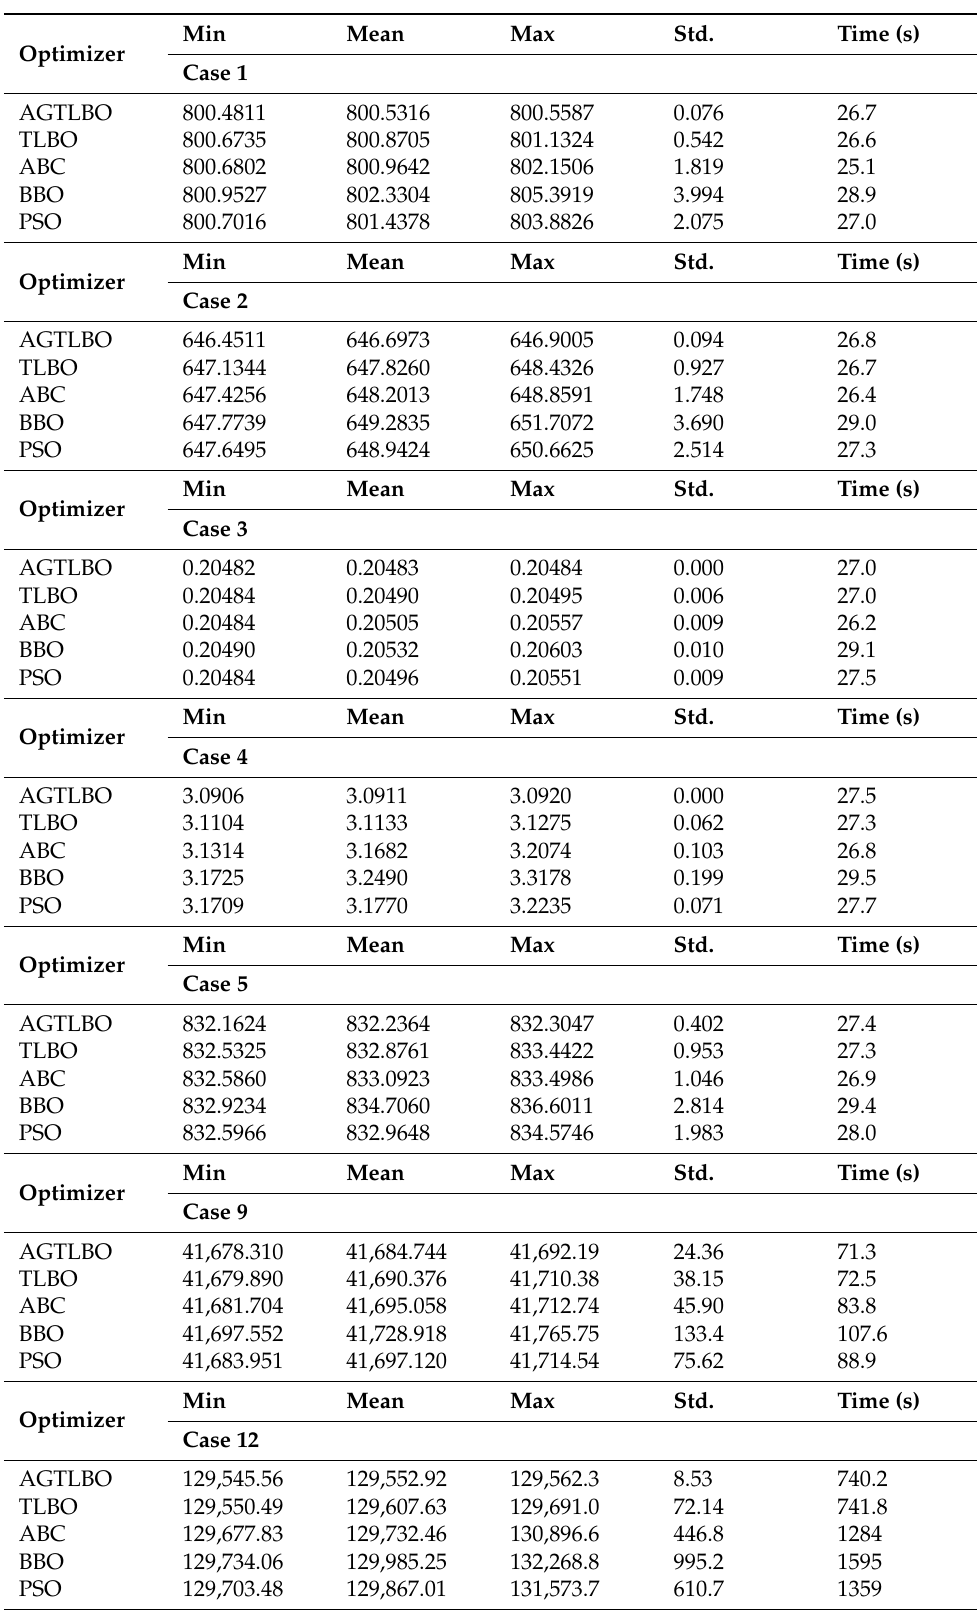
Table 18. Statistical results to show the performance of proposed AGTLBO and other